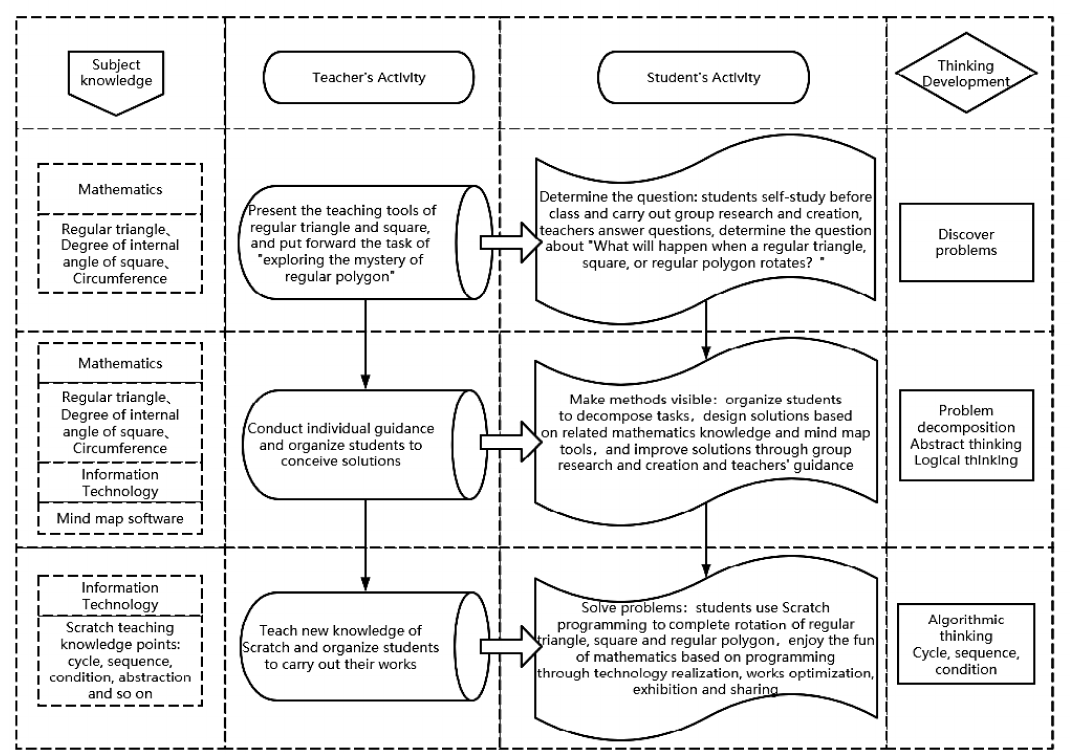
Figure 2. The specific activities for the teaching theme, “I’m an explorer: Discovering the mystery of regular